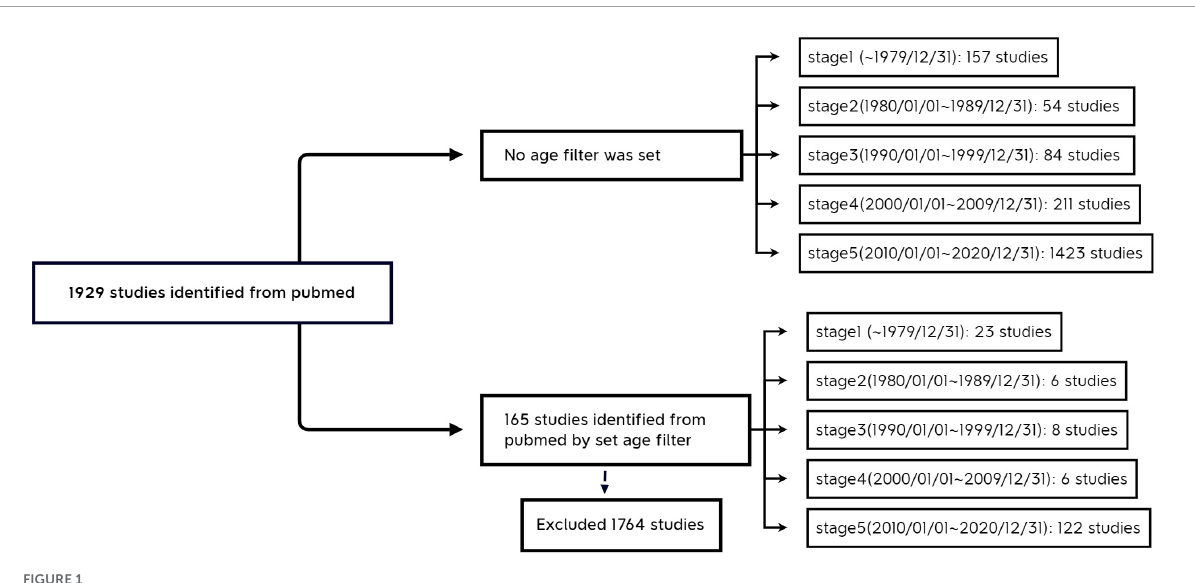
FIGURE1 Research